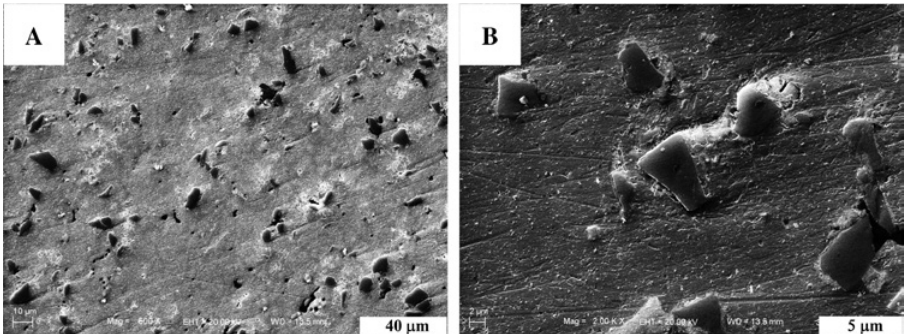
/Al2014 composites. p oxidation process creates an SiO layer on SiC particle sur- 2 faces. The SiO layer reacts with Al during mechanical stir- 2